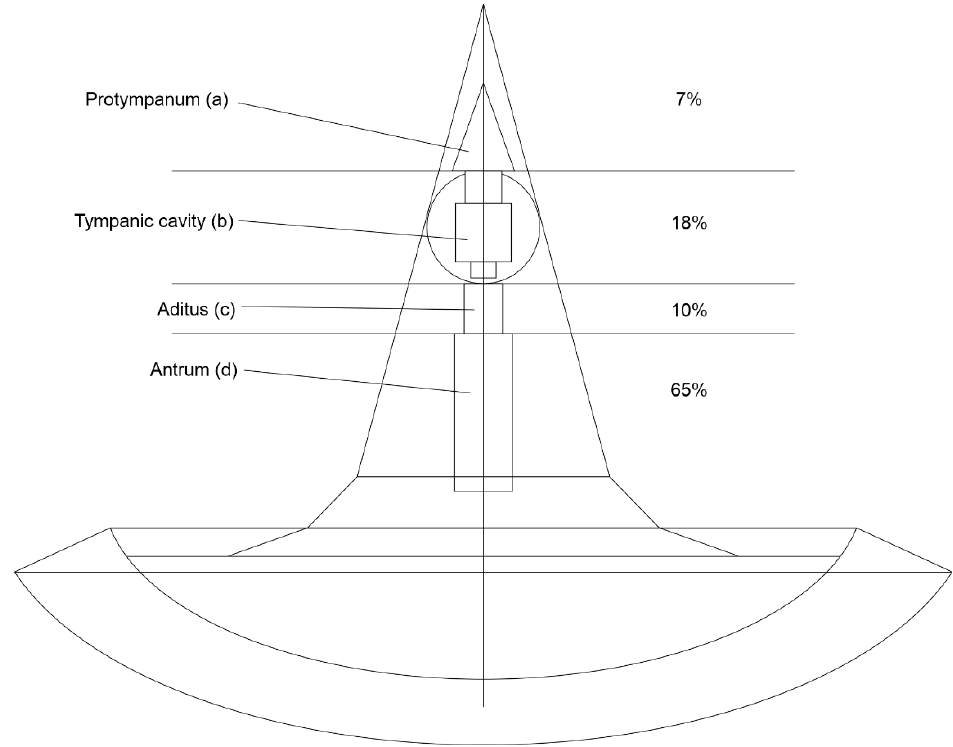
Figure 8. Endo-temporal three-dimensional representation of the D-Organ expressed by numerical values of the weight of its topographic divisions: ( a ) segment around the Protympanum 7% of D- cell population; ( b ) segment around the Tympanic cavity 18%; ( c ) segment around the Aditus 10%; ( d ) segment around the Antrum 65%.